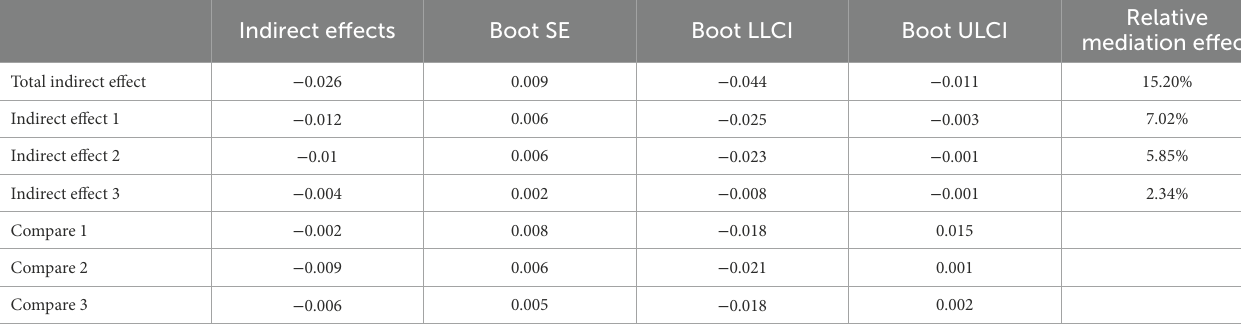
TABLE 4 Sleep quality and depression in the mediation effect analysis.